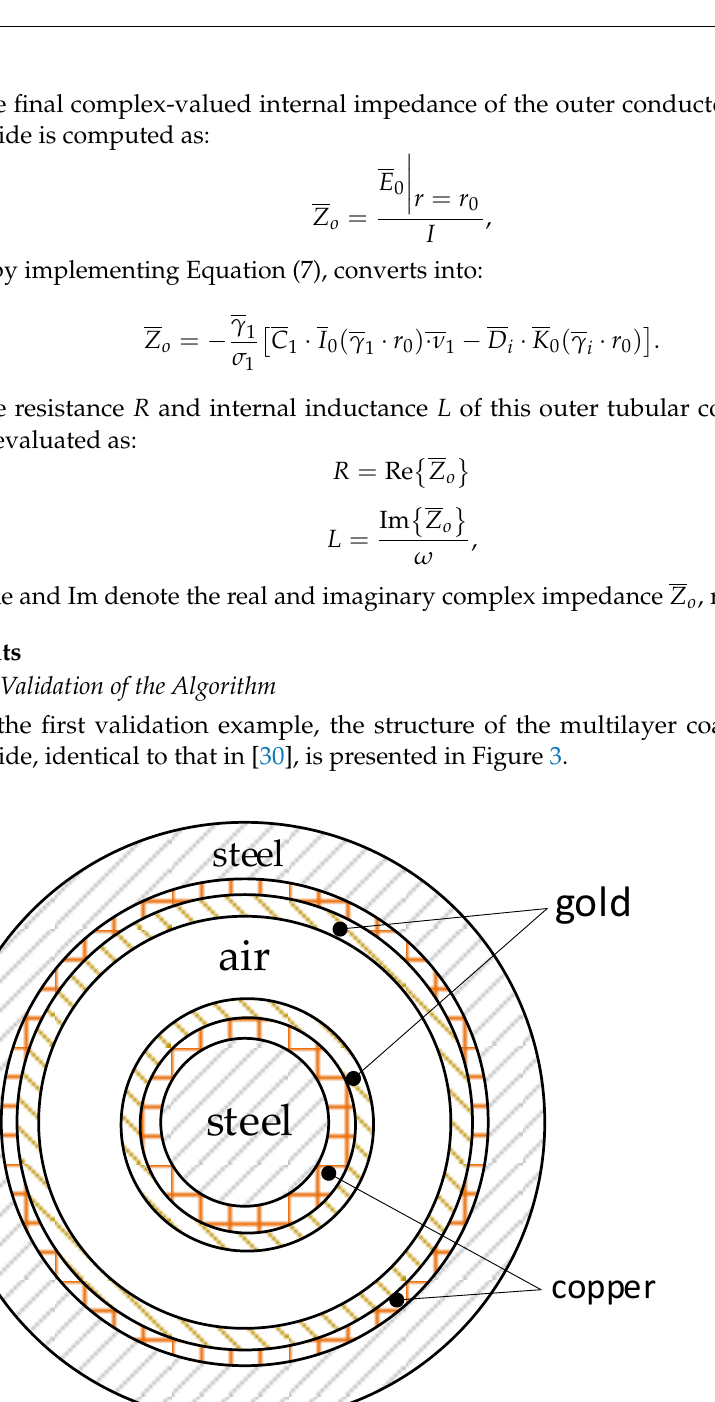
reverse order: the first (counting from the inside) is 5 μm thick gold, then 10 μm thick copper and finally stainless steel pipe, equal to a 100 μm thick wall. The innermost radius of the outer structure is 1.6 mm. The dielectric placed between the conductors is air, whose relative permeability and permittivity is equal to 1.00054 and 1, respectively. The electrical conductivity of air was ignored. The equations given in Sections 2 and 3 were translated into the MATLAB language. The constants and layer thicknesses of the waveguide were used as input data to the MATLAB model. The same data were incorporated into the MATLAB script based on the algorithm presented in [30]. As with those above, the geometry was prepared in the COM- SOL Multiphysics FEM software. The results of the module of the characteristic imped- ance, resistance per unit length (p.u.l.) and inductance p.u.l. are presented in Tables 1, 2 and 3, respectively. Table 1. Comparison of the characteristic impedance for the first validation example. f , Hz